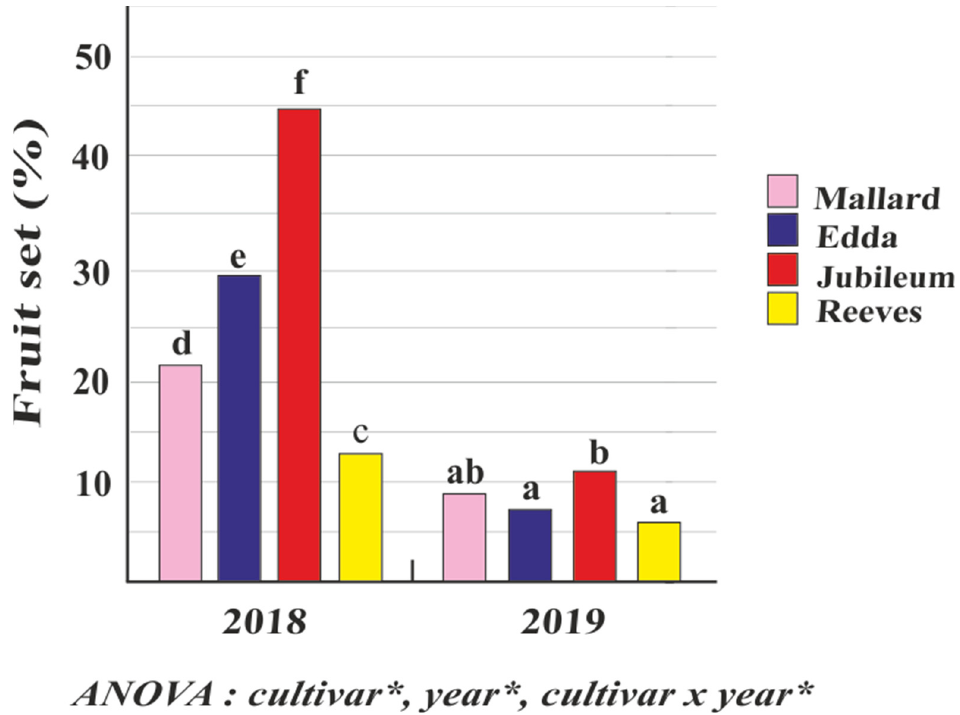
Figure 5. Fruit set in the plum cultivars ‘Mallard’, ‘Edda’, ‘Jubileum’, and ‘Reeves’ during 2018 and 2019 in open-pollination conditions. (Different letters above the bars denote a significant difference between cultivars according to the LSD test, p < 0.05; asterisk (*) very significant differences).